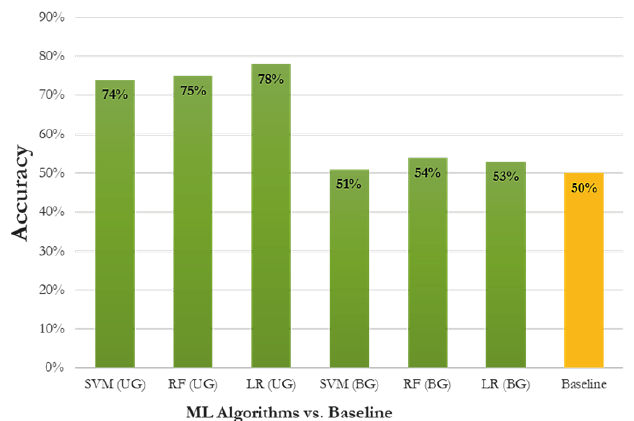
Fig. 4. Accuracy of ML models vs. baseline model for the sentiment classification phase.